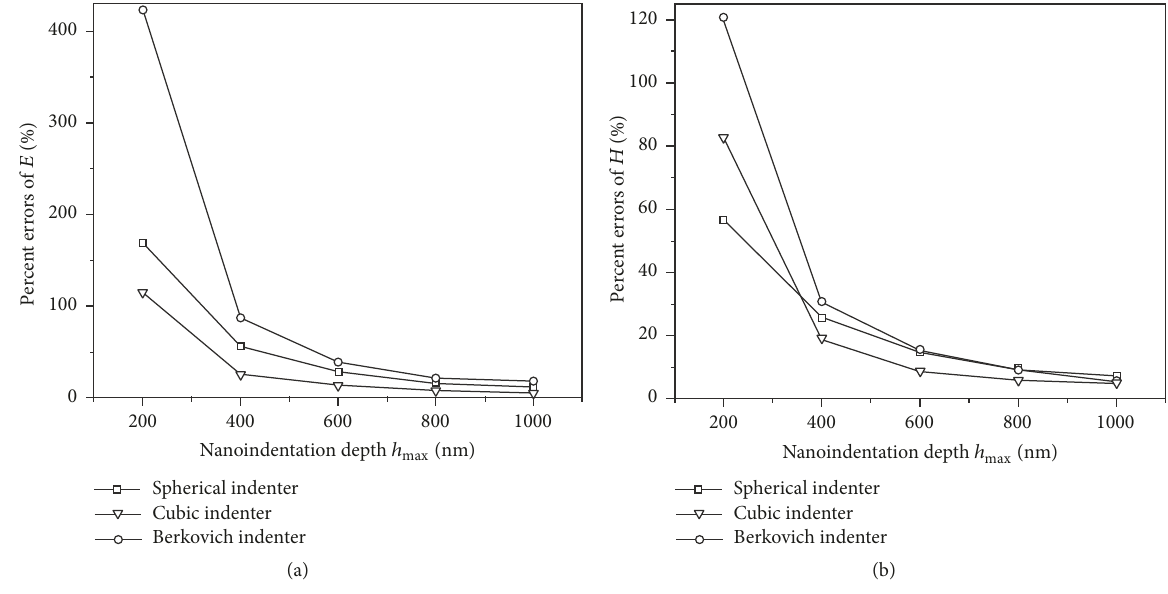
Figure 4: (a) Percent errors of elastic modulus for different indenters with immersion indentation compared with traditional indentation. (b) Percent errors of hardness for different indenters with immersion indentation compared with traditional